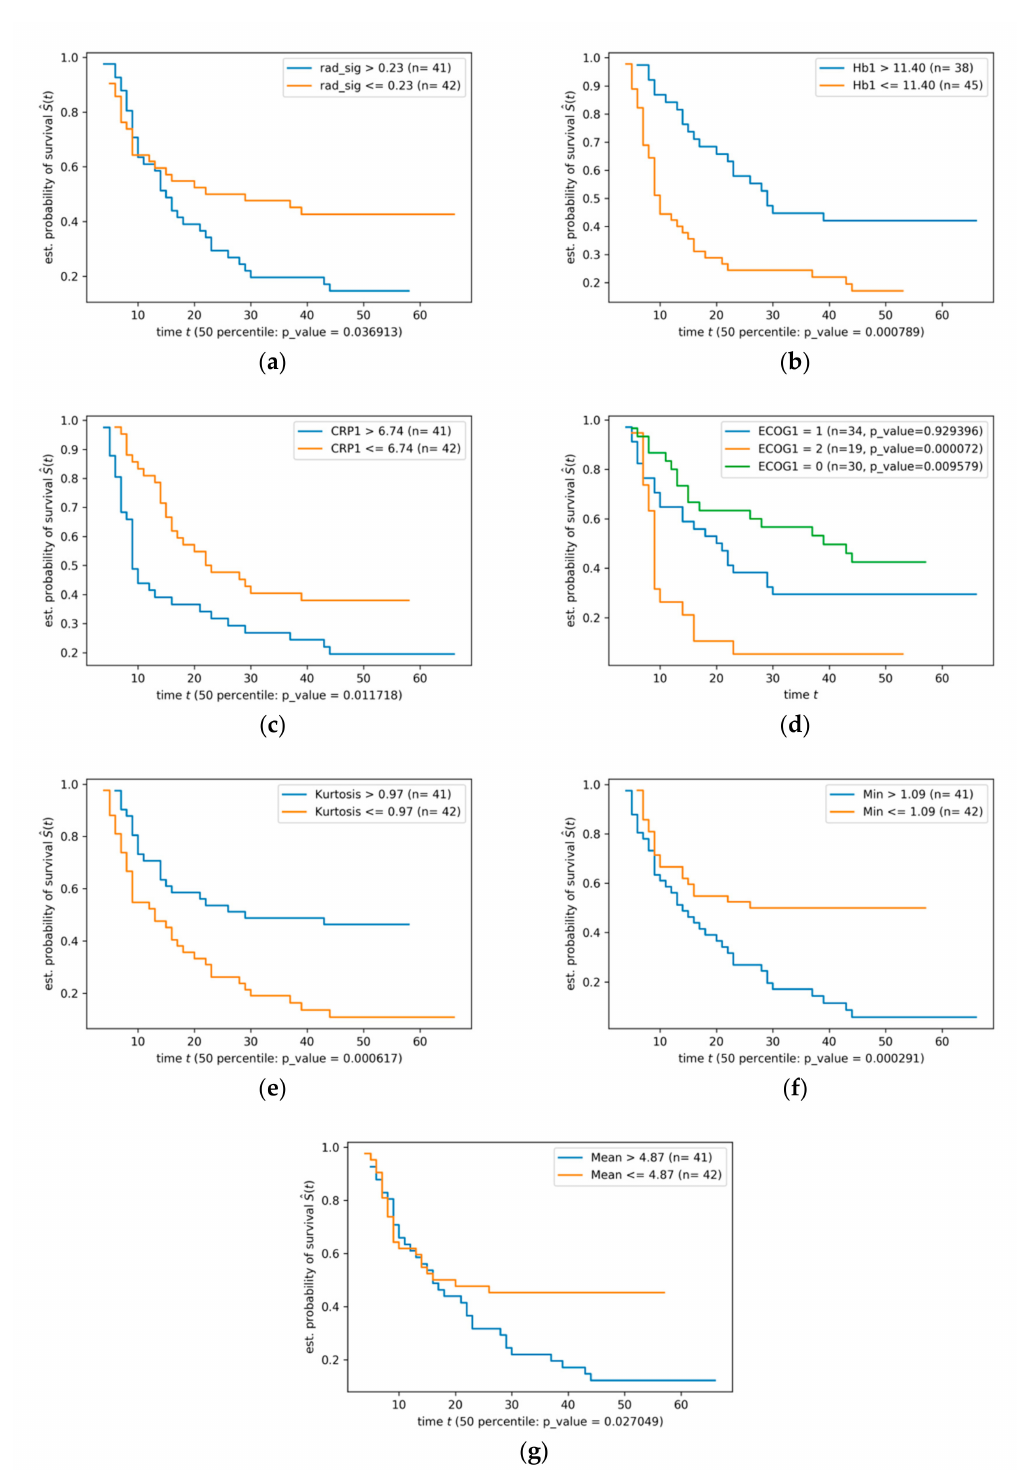
Figure 3. The results of Kaplan–Meier analyses for ( a ) radiomics signature, ( b ) Hb1, ( c ) CRP1, ( d ) ECOG1, ( e ) kurtosis, ( f ) SUV Min , and ( g ) SUV Mean